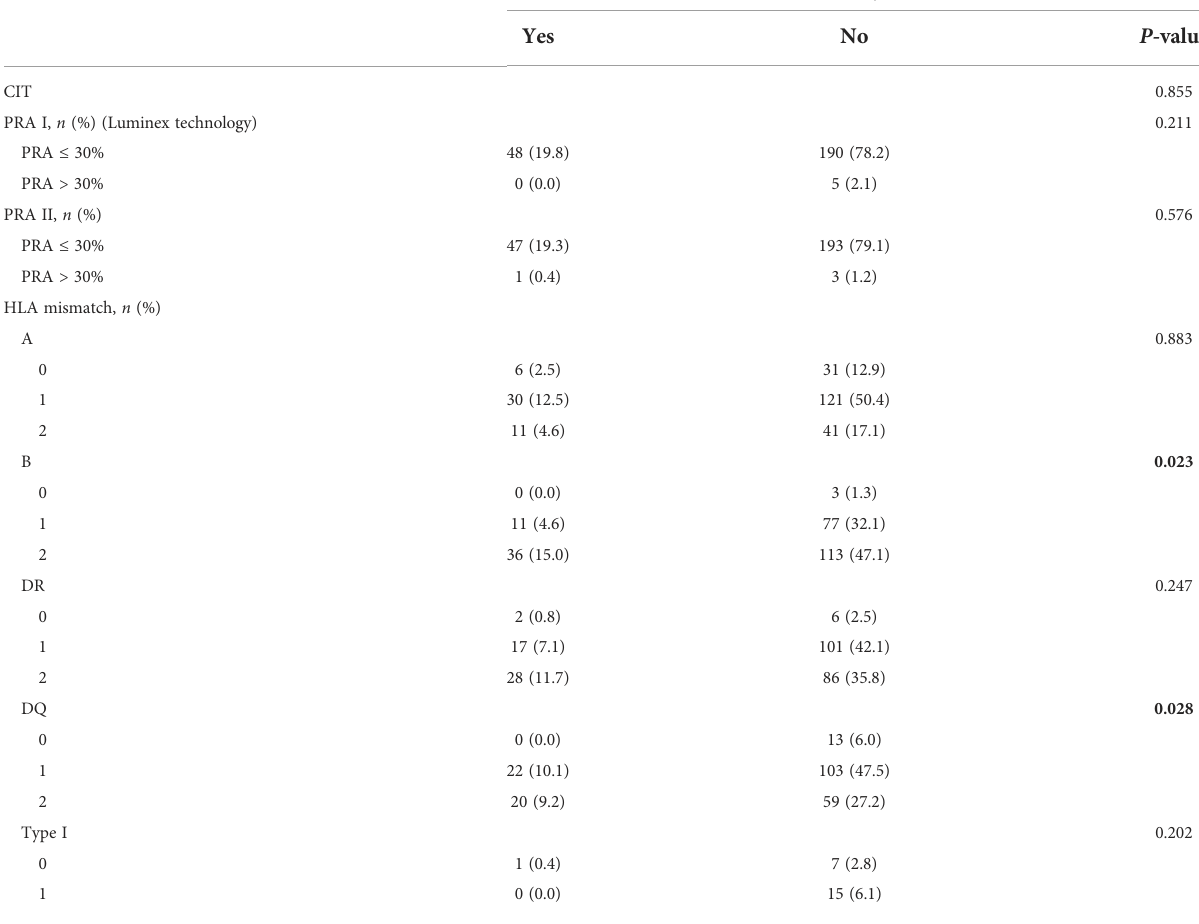
TABLE 2 Transplantation-related features and their association with treated